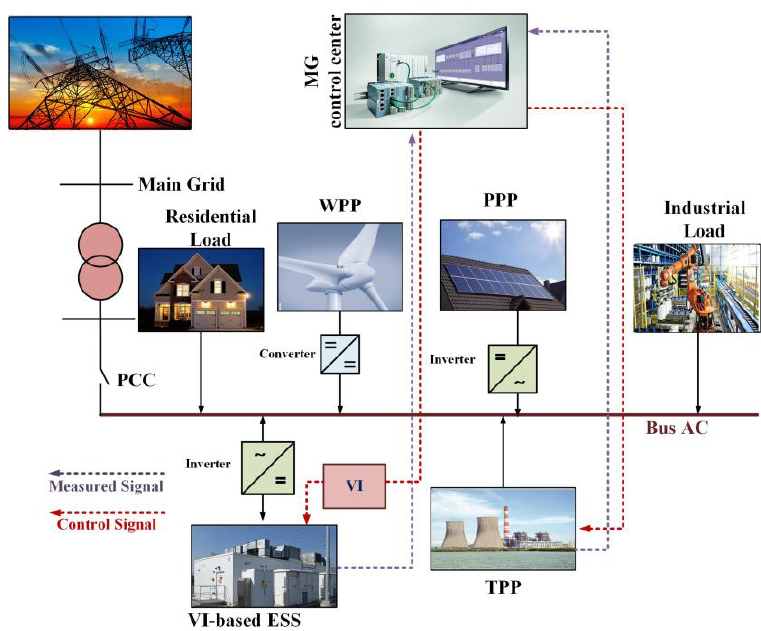
Figure 1. Schematic of the studied MG.